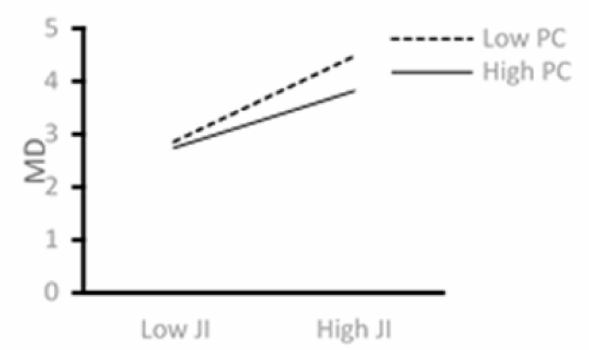
Figure 2. The moderating role of PC.